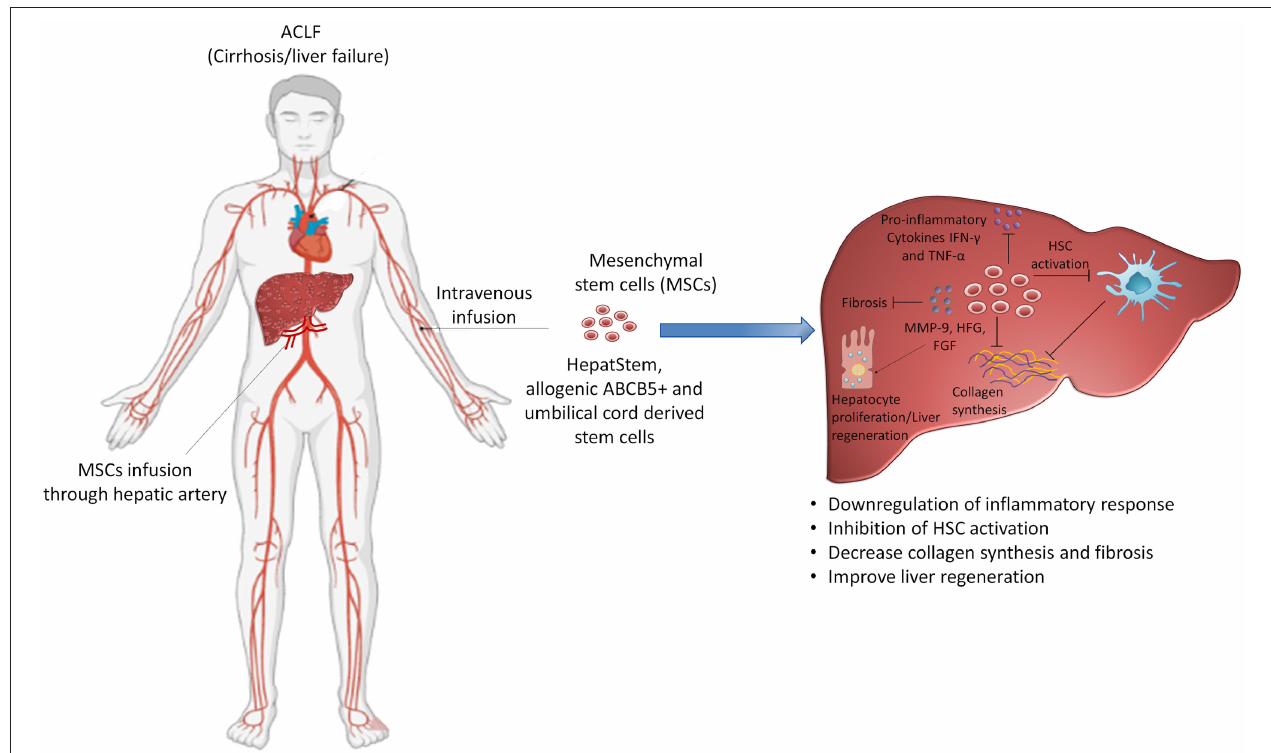
FIGURE 4 | Targeting stem cell therapy for the treatment of ACLF. Use of mesenchymal stem cells is under consideration and is being investigated in clinical trials for the treatment of ACLF. Mesenchymal stem cells possess different functions including the suppression of hyperactive inflammatory response, inhibition of hepatic stellate cell activation and collagen synthesis, reducing fibrosis and inducing liver regeneration. The diverse role of mesenchymal stem cells may benefit patients with ACLF and emerge as a potential therapeutic option for these patients. HSC: hepatic stellate cells. Some parts of this figure (Human structure) were prepared with the help of BioRender.